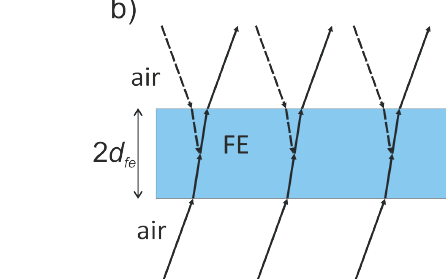
Figure A1. Schematic of the equivalence between the reflection ( a ) and transmission ( b ) cases of the wave incident on the ferroelectric